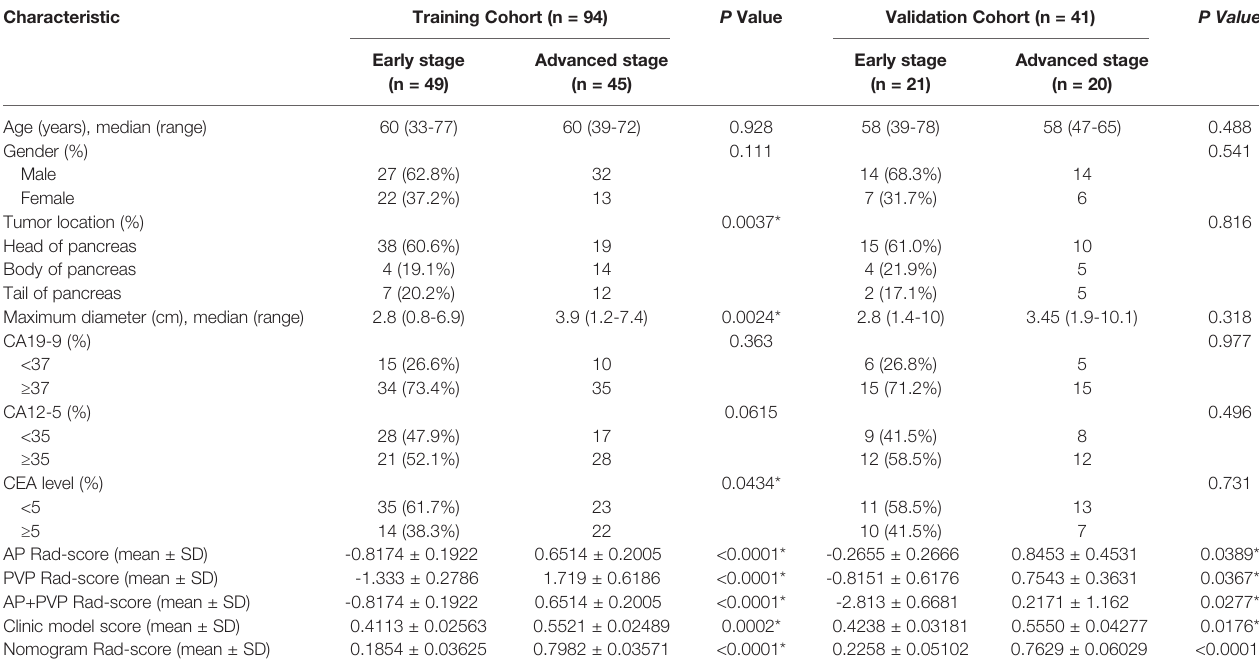
TABLE 1 | Characteristics of patients in the training and validation